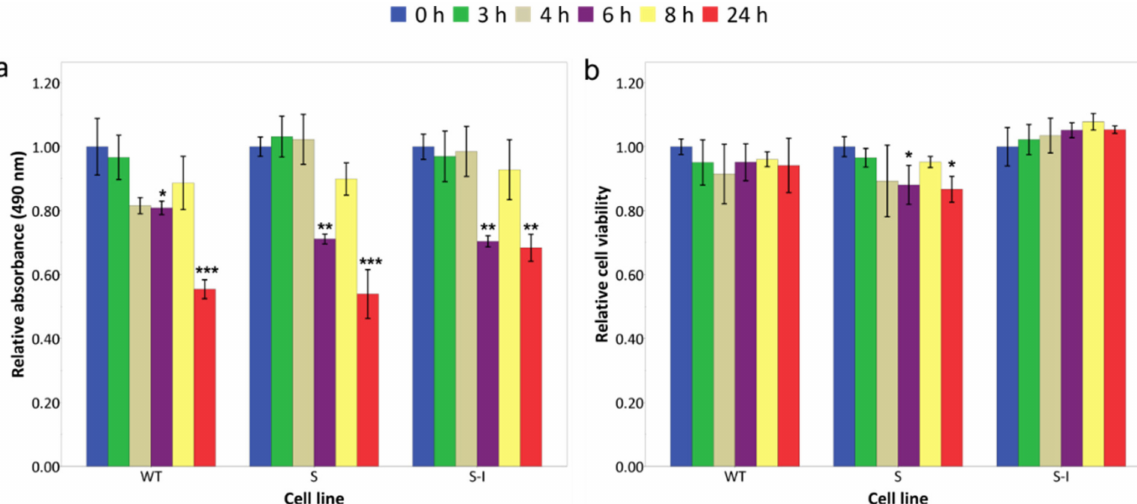
Figure 4. Effect of Tm on proliferation and cell viability in a FAD cell-model system. Cell proliferation and viability of differentiated stressed cells were analysed by ( a ) MTS assay and ( b ) trypan blue dye exclusion method following the incubation of cells with Tm for the indicated time points. Values represent the means for ( a ) n = 3; ± SD and independent of ( b ) representing two independent experiments where the technical replicates for each experiment were n = 3 and n = 2, respectively. For 24 h the means are from n = 3. The results are presented in relation to the zero-hour Tm treatment. Statistically significant differences demonstrated on the graph are from cells treated with Tm for zero hours compared with the cells treated with Tm for 3 h, 4 h, 6 h, 8 h, or 24 h, respectively. * p < 0.05, ** p < 0.01, *** p <